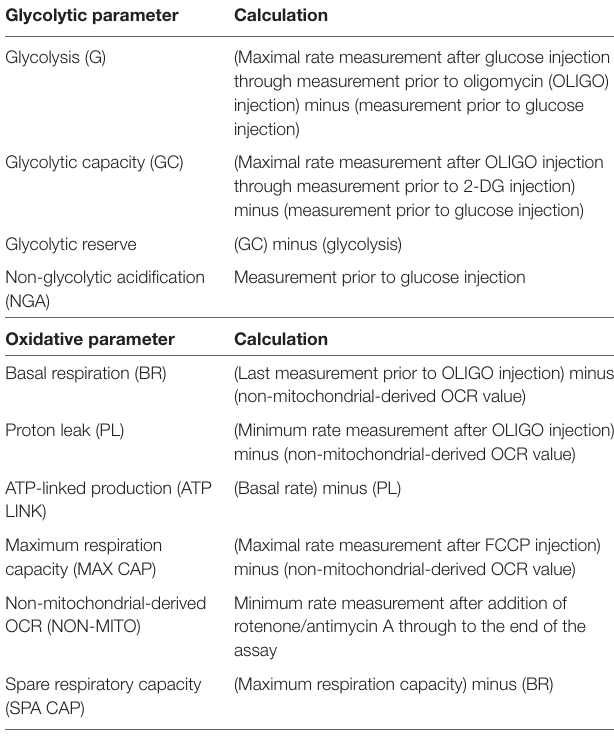
Table 1 | Calculation of glycolytic and oxidative